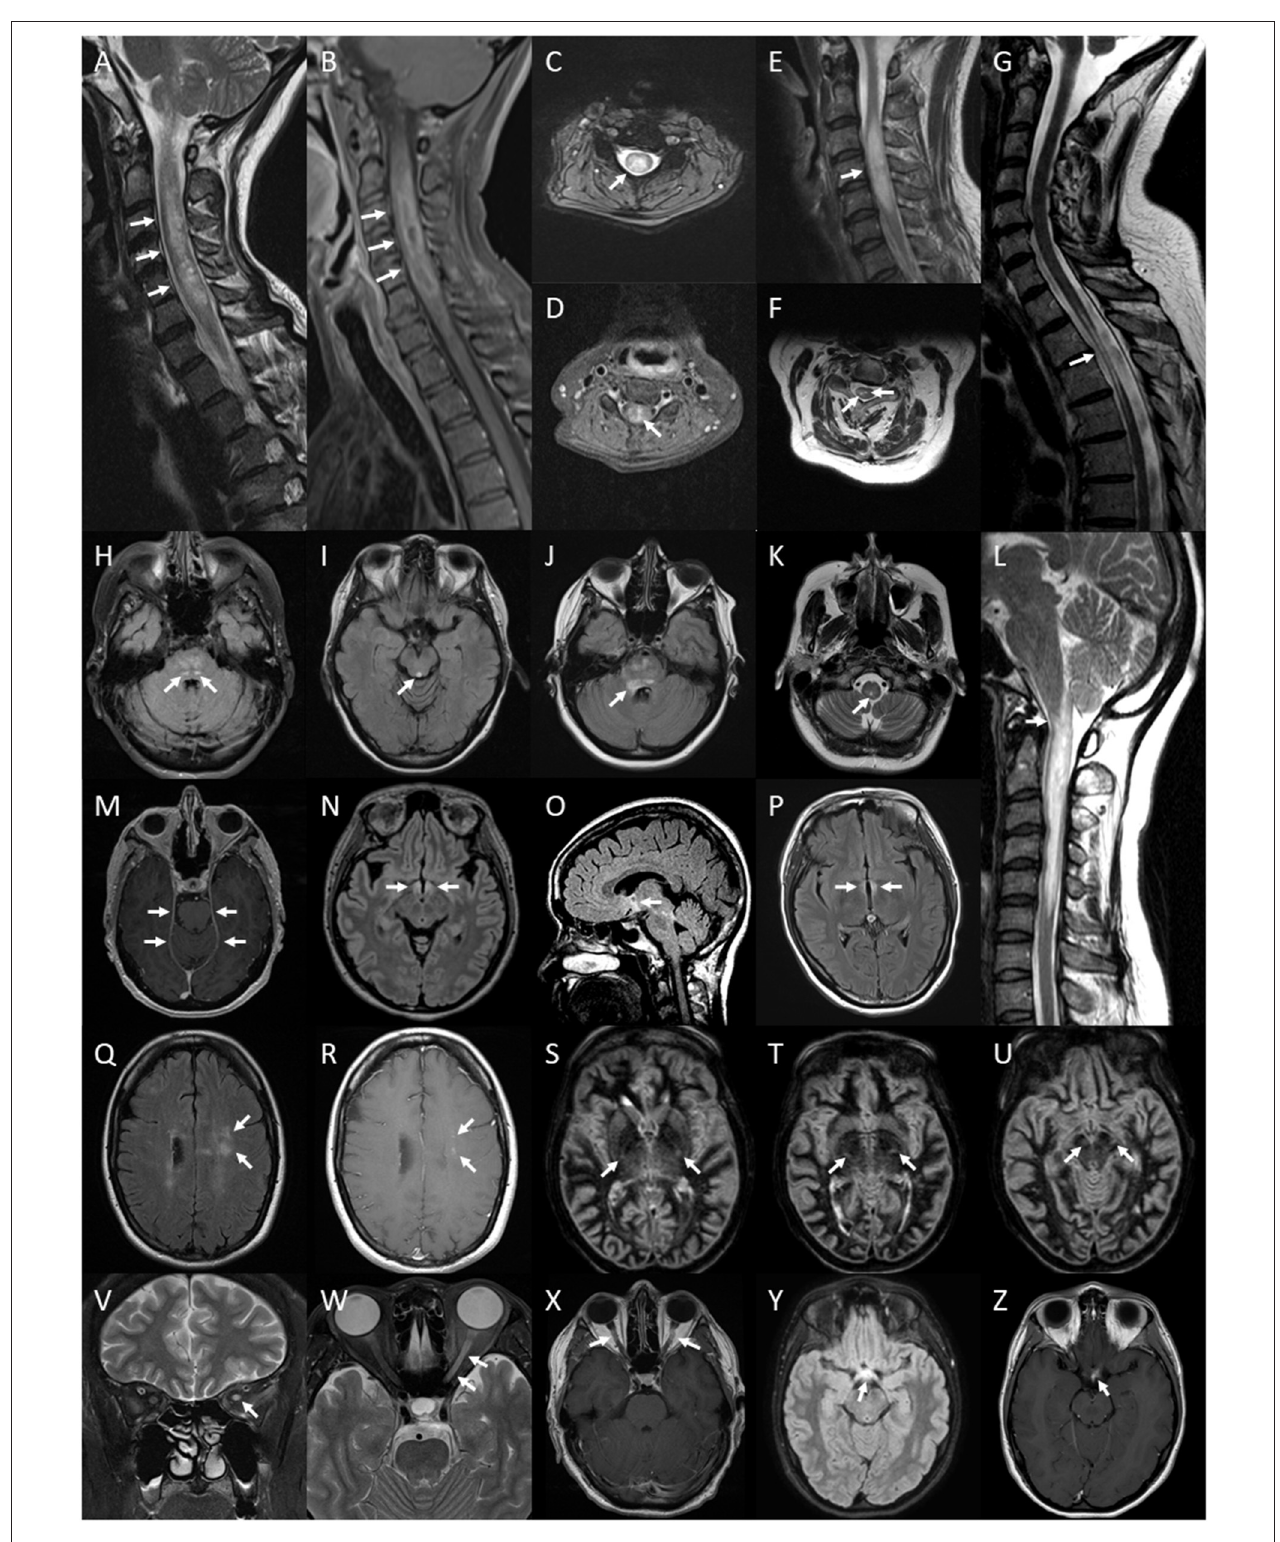
FIGURE 5 | Lesions of the spinal cord, brain and optic nerve associated with or exclusively seen in NMOSD. Spinal cord lesions: longitudinally extensive spinal cord lesion (arrows) seen on T2 sagittal image of the cervical cord (A) , peripheral Gd-enhancing lesion (arrows) seen on T1 sagittal image of the same lesion (B) , central cord lesion (arrow) on T2 axial image at the level of C4 from the same lesion (C) and central Gd-enhancement (arrow) on T1 axial image in the same region (D) ; swelling (arrow) of a high signal lesion on T2 sagittal image of the cervical region (E) ; bright spotty cord lesions (arrows) on axialT2 image of the cervical region (F)